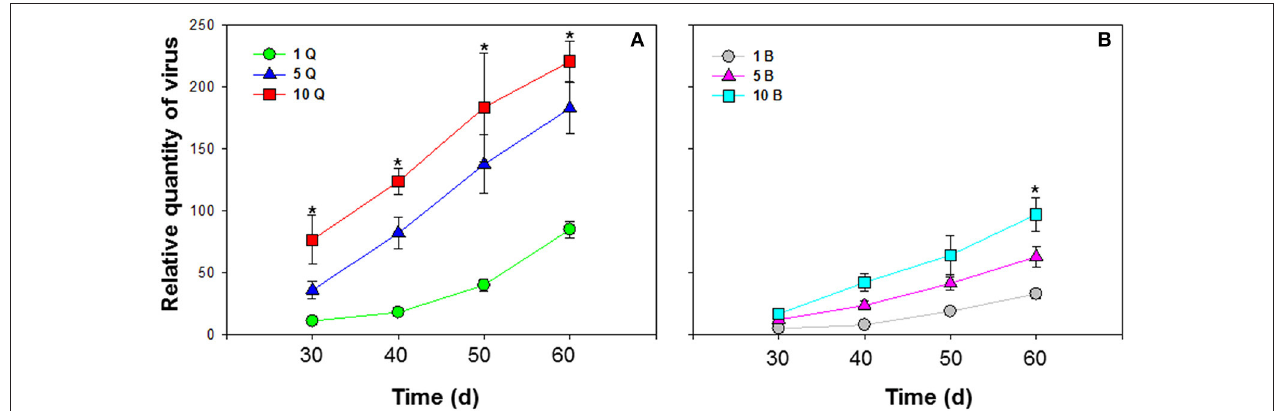
FIGURE 4 | Accumulation of tomato chlorosis virus in tomato following transmission by different numbers of B. tabaci MEAM1 and MED females. (A) Accumulation of ToCV transmitted by different numbers of MED females. (B) Accumulation of ToCV transmitted by different numbers of MEAM1 females. 1 Q, 1 MED female; 5 Q, 5 MED females; 10 Q, 10 MED females; 1 B, 1 MEAM1 female; 5 B, 5 MEAM1 females; 10 B, 10 MEAM1 females. In the legend, 1, 5, and 10 indicate the number of MEAM1 or MED females added per clip-cage (one clip-cage per plant). The Y axis values refer to the relative quantity of virus detected in the two youngest leaves of each replicate plant. Values are means ± SE at P < 0.05; N = 10. An asterisk indicates a significant difference for MEAM1 (or MED) among number of 1, 5, or 10 at the same time point at P < 0.05.